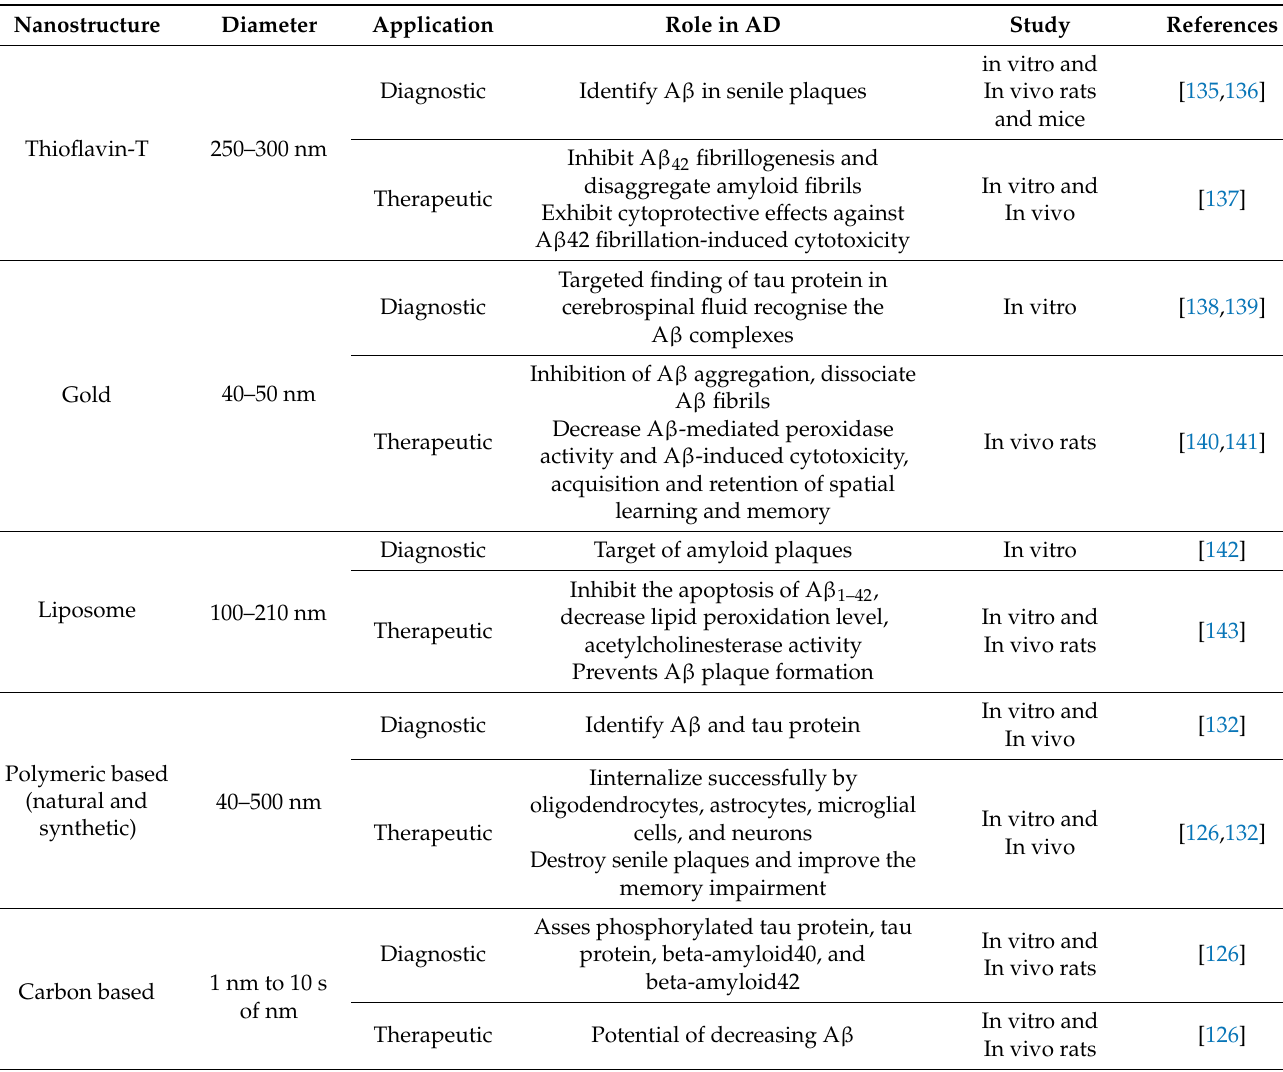
Table 2. Different types of nanoformulations/biosensors in the diagnosis/therapy of